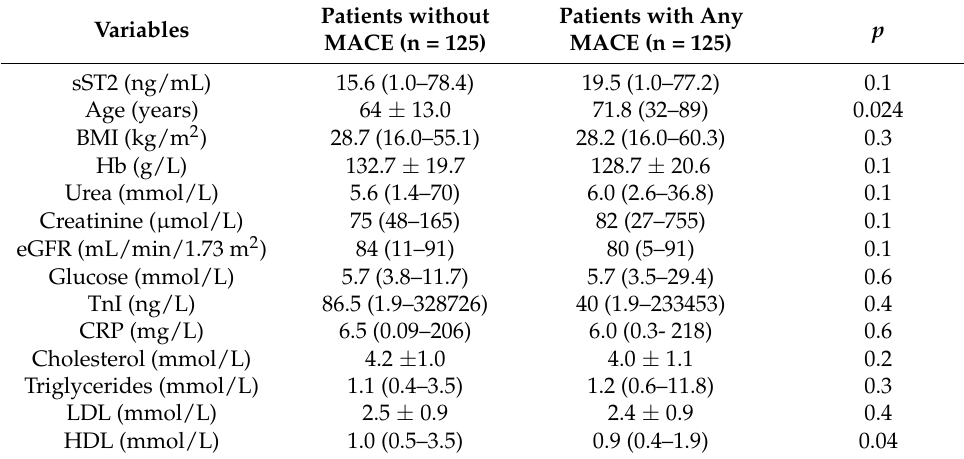
Table 4. Comparison of biochemistry levels between patients with or without MACE (statistics: Student’s t -test or Mann–Whitney test, as appropriate).